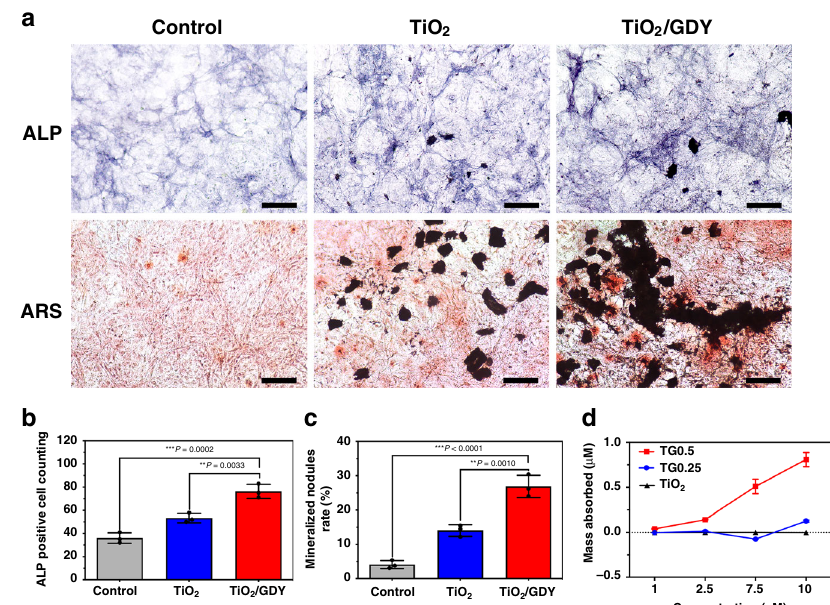
Fig. 4 Osteogenic effect of TiO 2 /GDY and TiO 2 in vitro. MC3T3-E1 cells were cultured with TiO 2 , TiO 2 /GDY or PBS under osteogenic induction. a Alkaline phosphatase activity (upper labeled ALP) and Alizarin Red S staining (lower labeled ARS) on day 14. b , c Semiquantitative analysis of ALP activity and ARS staining. d Loading capacity of dexamethasone on TiO 2 /GDY (TG0.25, TG0.5) and TiO 2 nano fi bers for 24 h. Scale bar = 100 μ m. The data are shown as the mean ± S.D., error bars = Standard Deviation ( n = 3 independent experiments). One-way ANOVA was applied for statistical analysis in b , c (* p < 0.05; ** p < 0.01; *** p < 0.001). Source data of b – d are provided as a Source Data fi